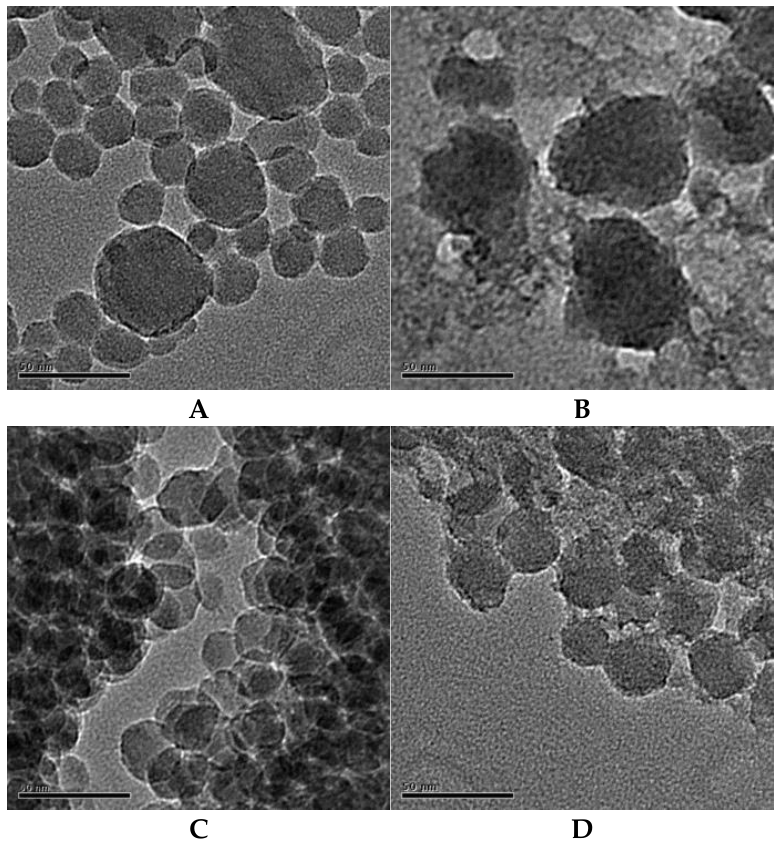
Figure 1. The TEM images of the test articles: sample A ( A ), modified sample A ( B ), sample B ( C ), modified sample B ( D ).